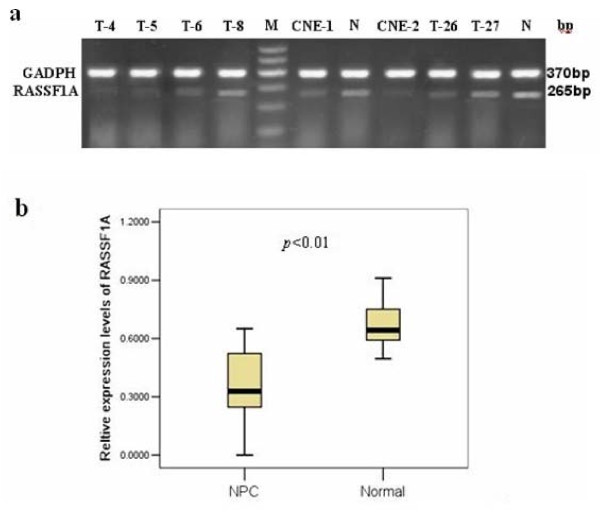
(a) Expression level of RASSF1A in NPC cell lines, normal nasopharyngeal epithelial and primary tumor biopsies by RT-PCR, T, primary nasopharyngeal tumor tissues; N, normal nasopharyngeal epithelial; M; marker I. GAPDH was amplified as an internal control. (b) Summary of overall expression of RASSF1A in 38 primary NPC tumors and 14 normal nasopharyngeal epithelial biopsies. RASSF1A expression was significantly down-regulated in NPC primary tumors compared with normal nasopharyngeal epithelial (p < 0.01, Mann-Whitney's U test).